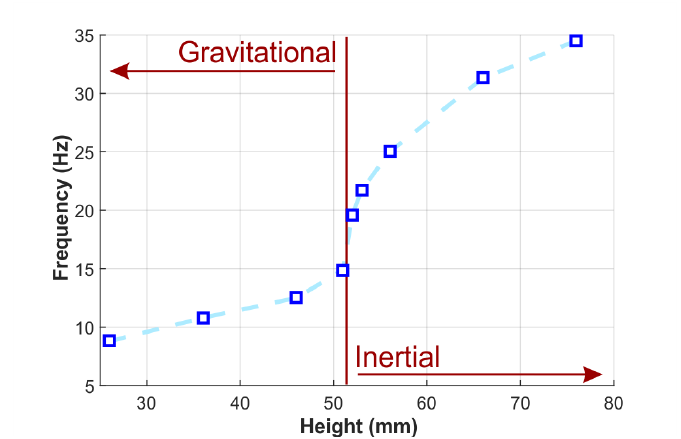
Figure 7. Frequency versus height for a series of steady flow rate tests of honey at 0.18 mL · s − 1 . Individual trials are denoted by blue squares. The dashed blue line represents linear interpolation between trials. The transition from gravitational to inertial flow between trials at 51 and 52 mm is